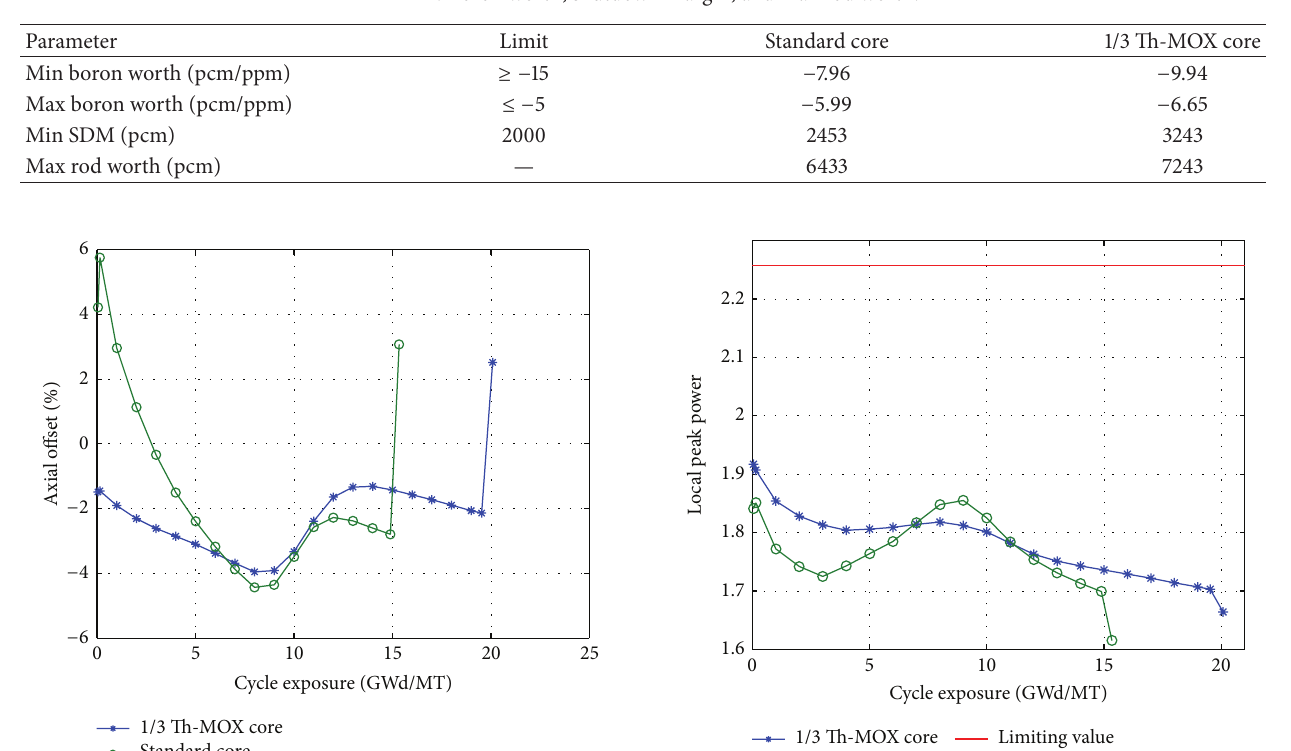
Table 1: Boron worth, shutdown margin, and max rod worth.